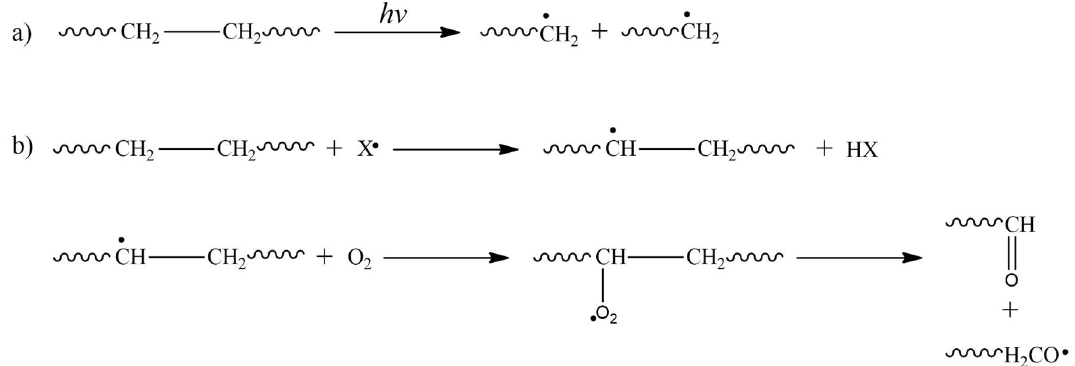
Figure 7. Representative schema of the HE-EMR-induced-cleavage. ( a ) C-C bond cleavage and ( b ) oxygen-induced cleavage, corresponding to an indirect degradation process.